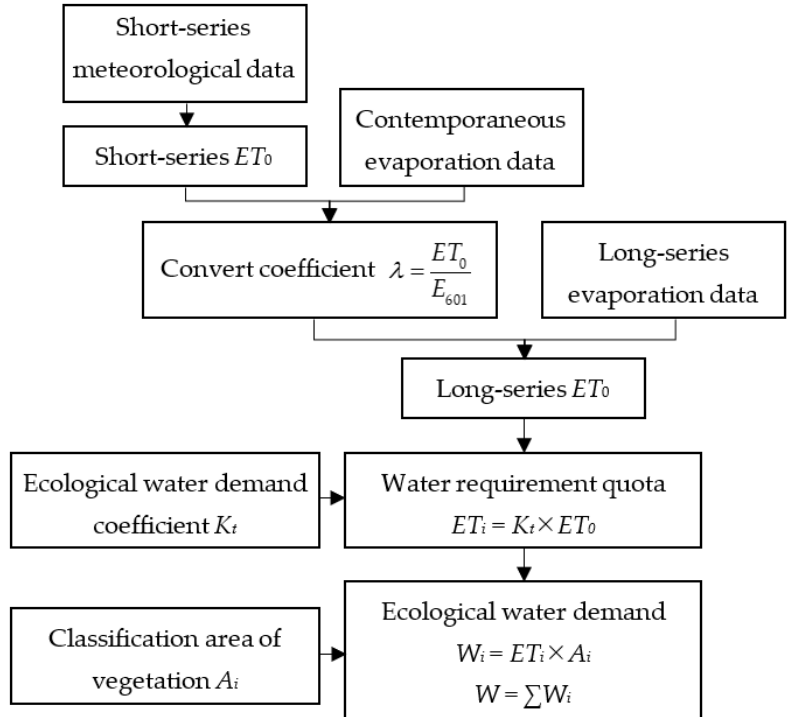
Figure 2. Process used to calculate ecological water demand. ET 0 is the reference crop evapotranspiration, λ represents the coefficient to convert water surface evaporation to reference crop evapotranspiration, E 601 is the water surface evaporation measured by an evaporating dish ϕ 601, ET i is the water requirement quota of different crops, K t is the ecological water demand coefficient, obtained from the Handbook of Irrigation Technology and related research results, A i represents the area of vegetation, W i is the ecological water demand of different vegetation, and W is the total ecological water demand.